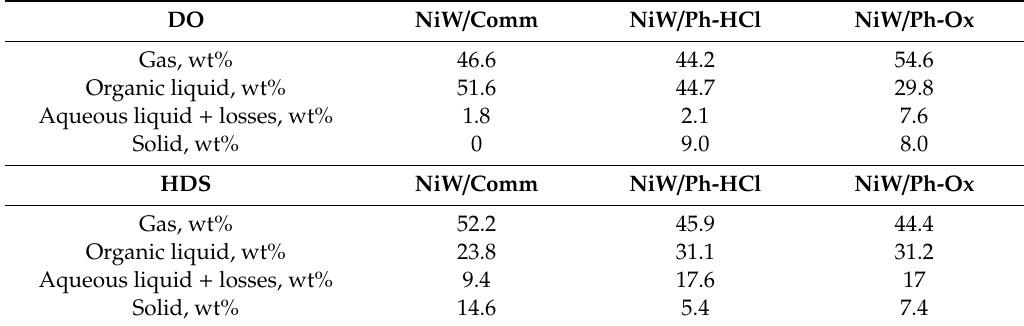
Table 4. Deoxygenation (DO) and hydrodesulfurization (HDS) mass balance of the products.